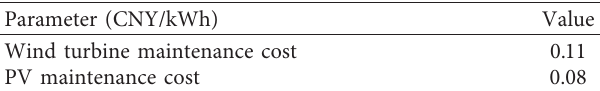
The total load demand curve of the residents is shown in Figure 18. This environment corresponds to four scenes, respectively. Scenario 1. Electric vehicle and air conditioner jointly participate in virtual energy storage.